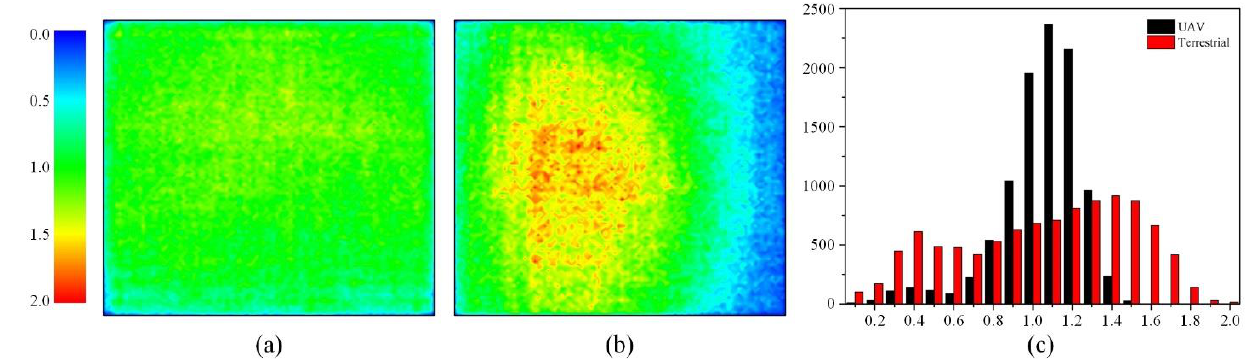
Figure 9. Tie point distributions for the Verwaltung dataset; ( a ) aerial (UAV) and ( b ) terrestrial image spaces; ( c ) histograms.